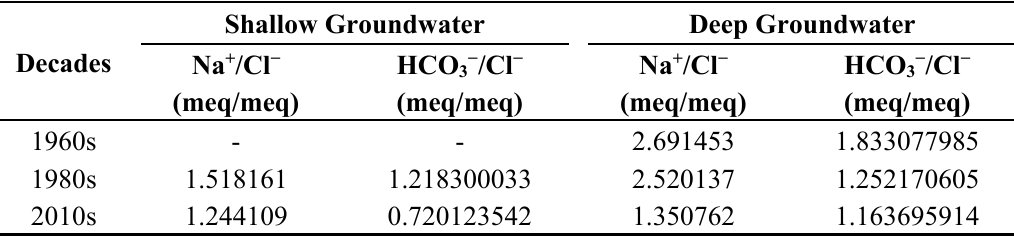
Table 2. Average ratio of milligram equivalents of Na + vs. Cl − and HCO 3 − vs. Cl − .